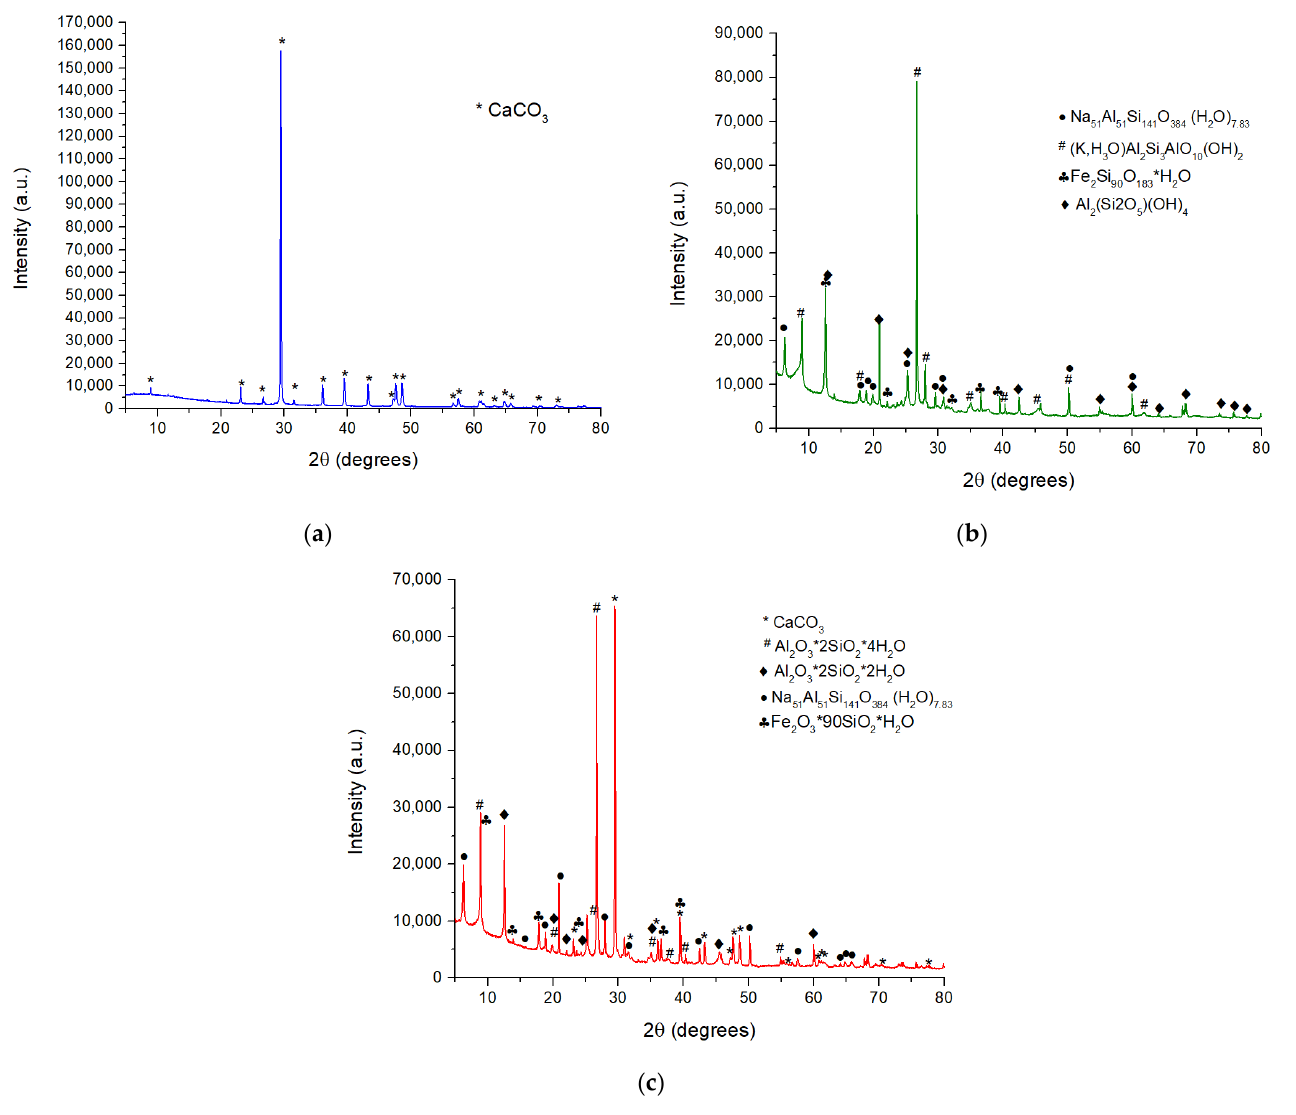
Figure 1. XRD patterns of ( a ) limestone; ( b ) clay; ( c ) marl.